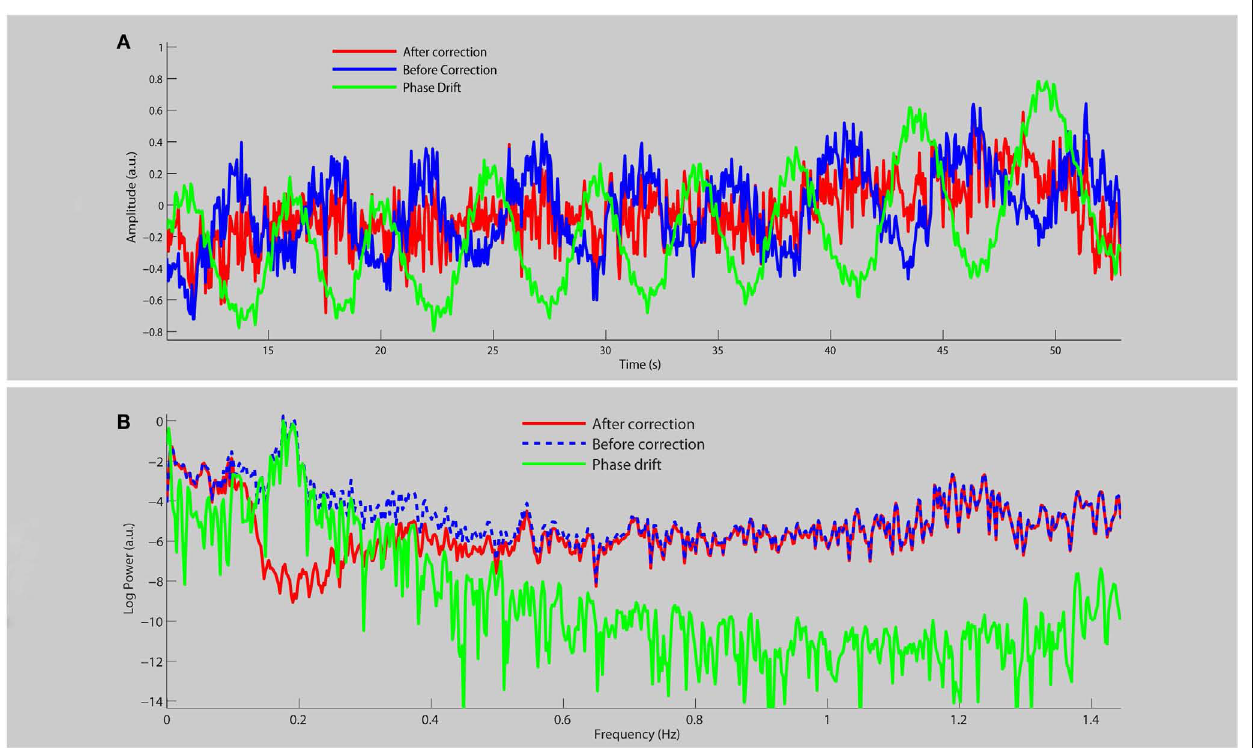
FIGURE 1 |A section of the average time course (A) and frequency spectrum on a log-linear scale (B) of RSNs for a single subject before (blue line) and after (red line) physiological noise removal, as well as the corresponding phase drift regressor (green line)